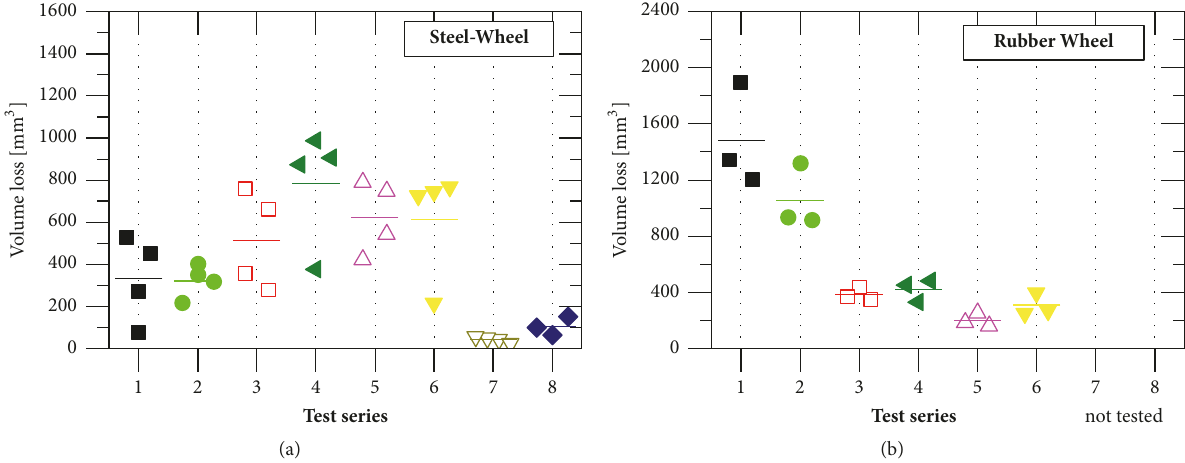
Figure 9: Volume loss of the tested series after 6000 rotations of the friction wheel made from steel (a) and a rubber wheel (b).